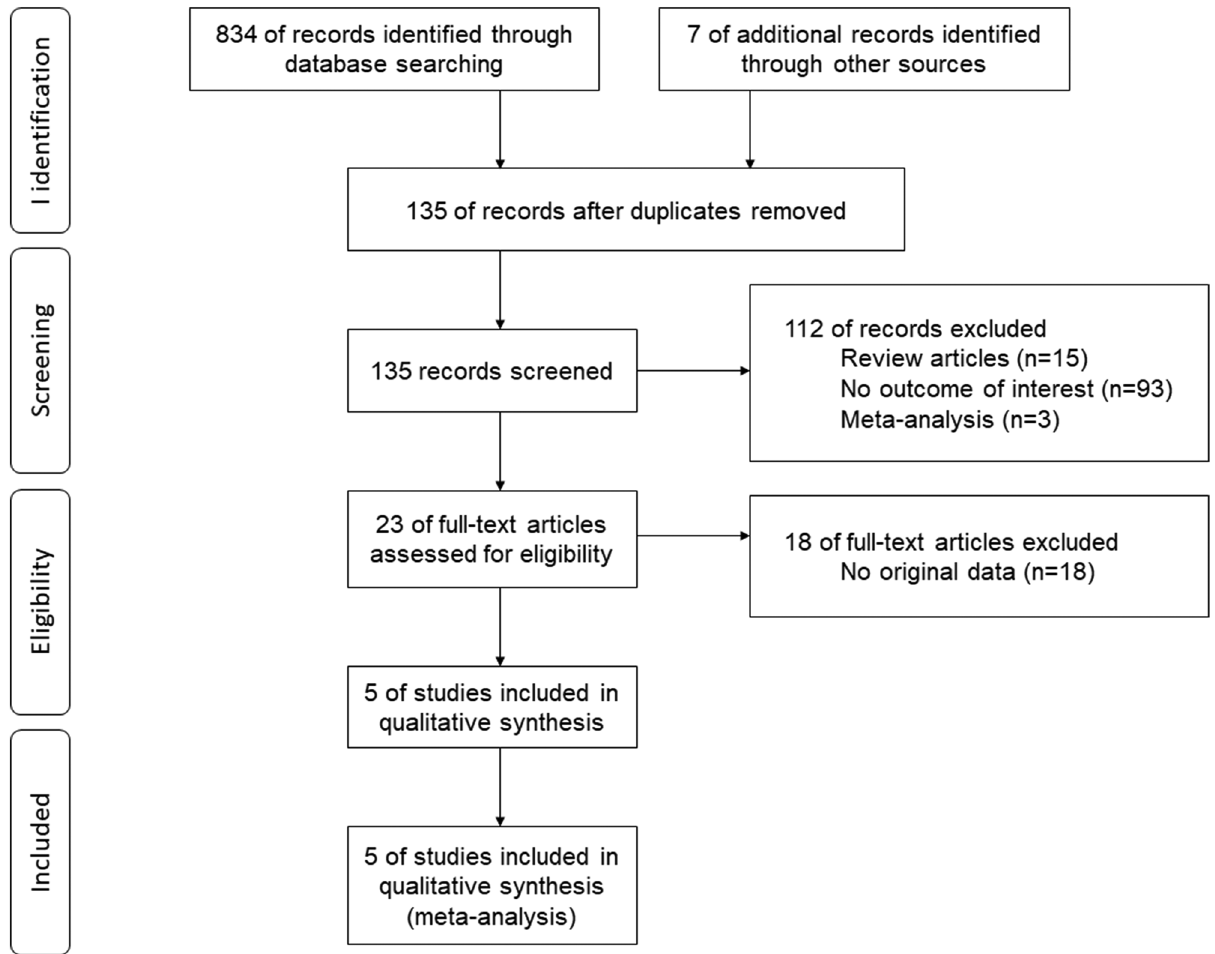
Figure 1: Flow diagram of the study selection